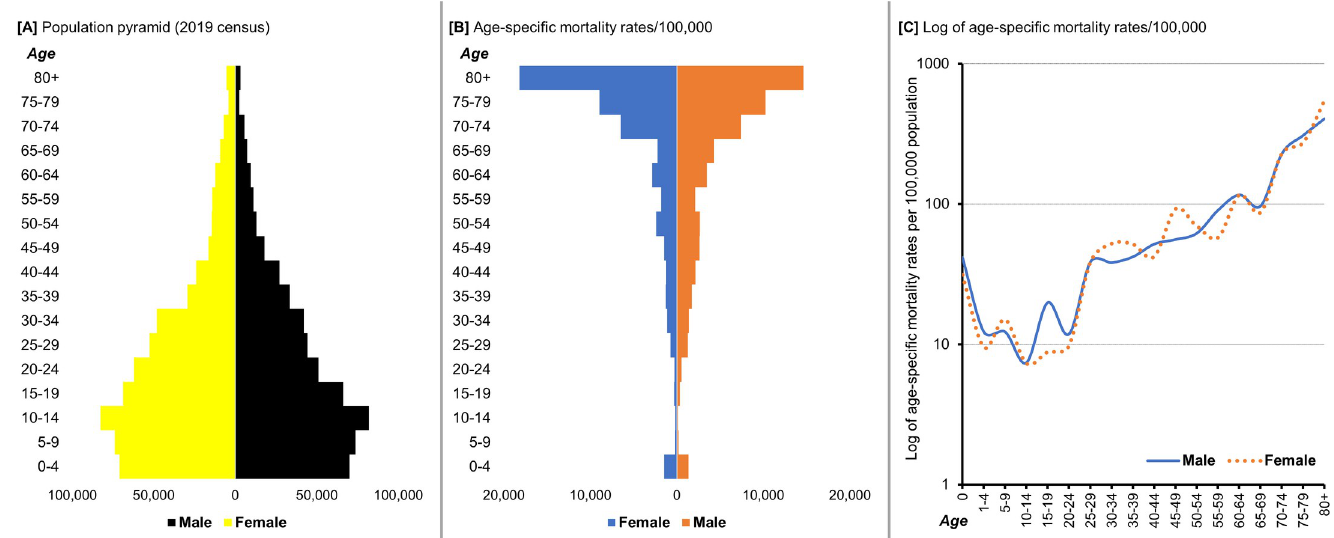
Fig 2. Population pyramid and estimated deaths per 100,000 by sex and age, Kisumu County, Kenya (2019). A) Source of population data is 2019 census, B) Estimated deaths/100,000 calculated using the population denominator, C) Log-transformed age-specific mortality rates/100,000 population.